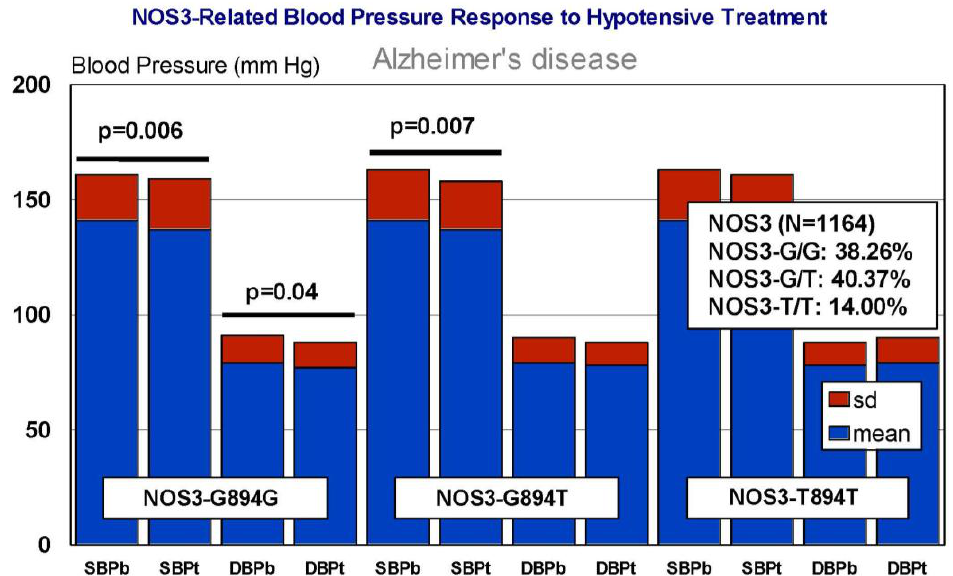
Figure 15. NOS3 -related blood pressure response to a hypotensive treatment. SBPb: Systolic blood pressure. SBPt: Systolic blood pressure (Enalapril, 10–20 mg/day). DBP: Diastolic blood pressure.